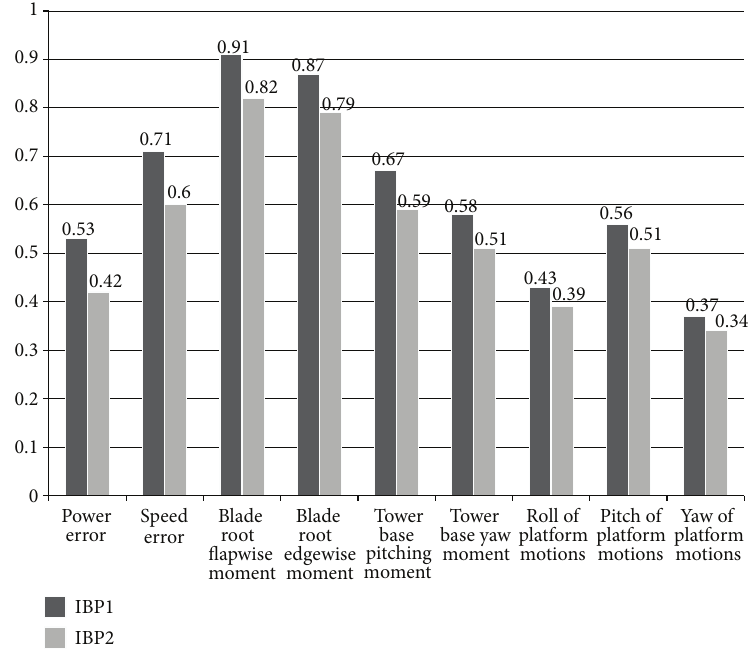
Figure 7: Comparison of averaged DLC for the barge platform with the baseline controller.